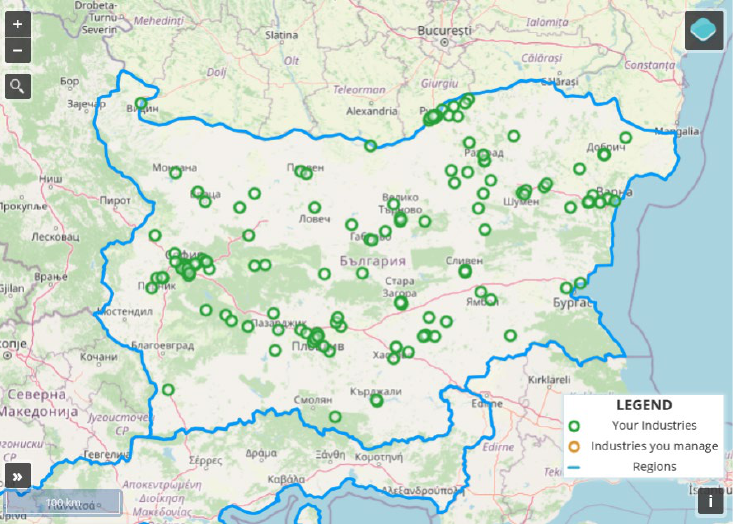
Figure 5. Map of Bulgarian participants (screenshot from www.swanplatform.eu, accessed on 13 May 2022). May 2022).